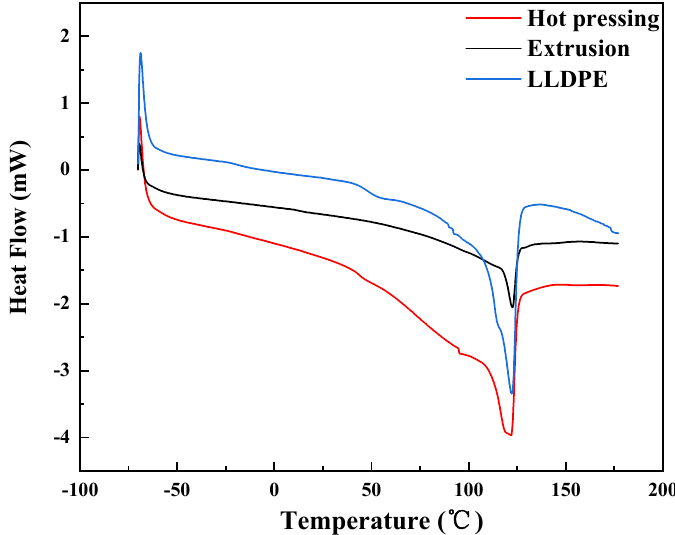
Figure 4. DSC image of hot pressed and extruded straw/LLDPE composite.